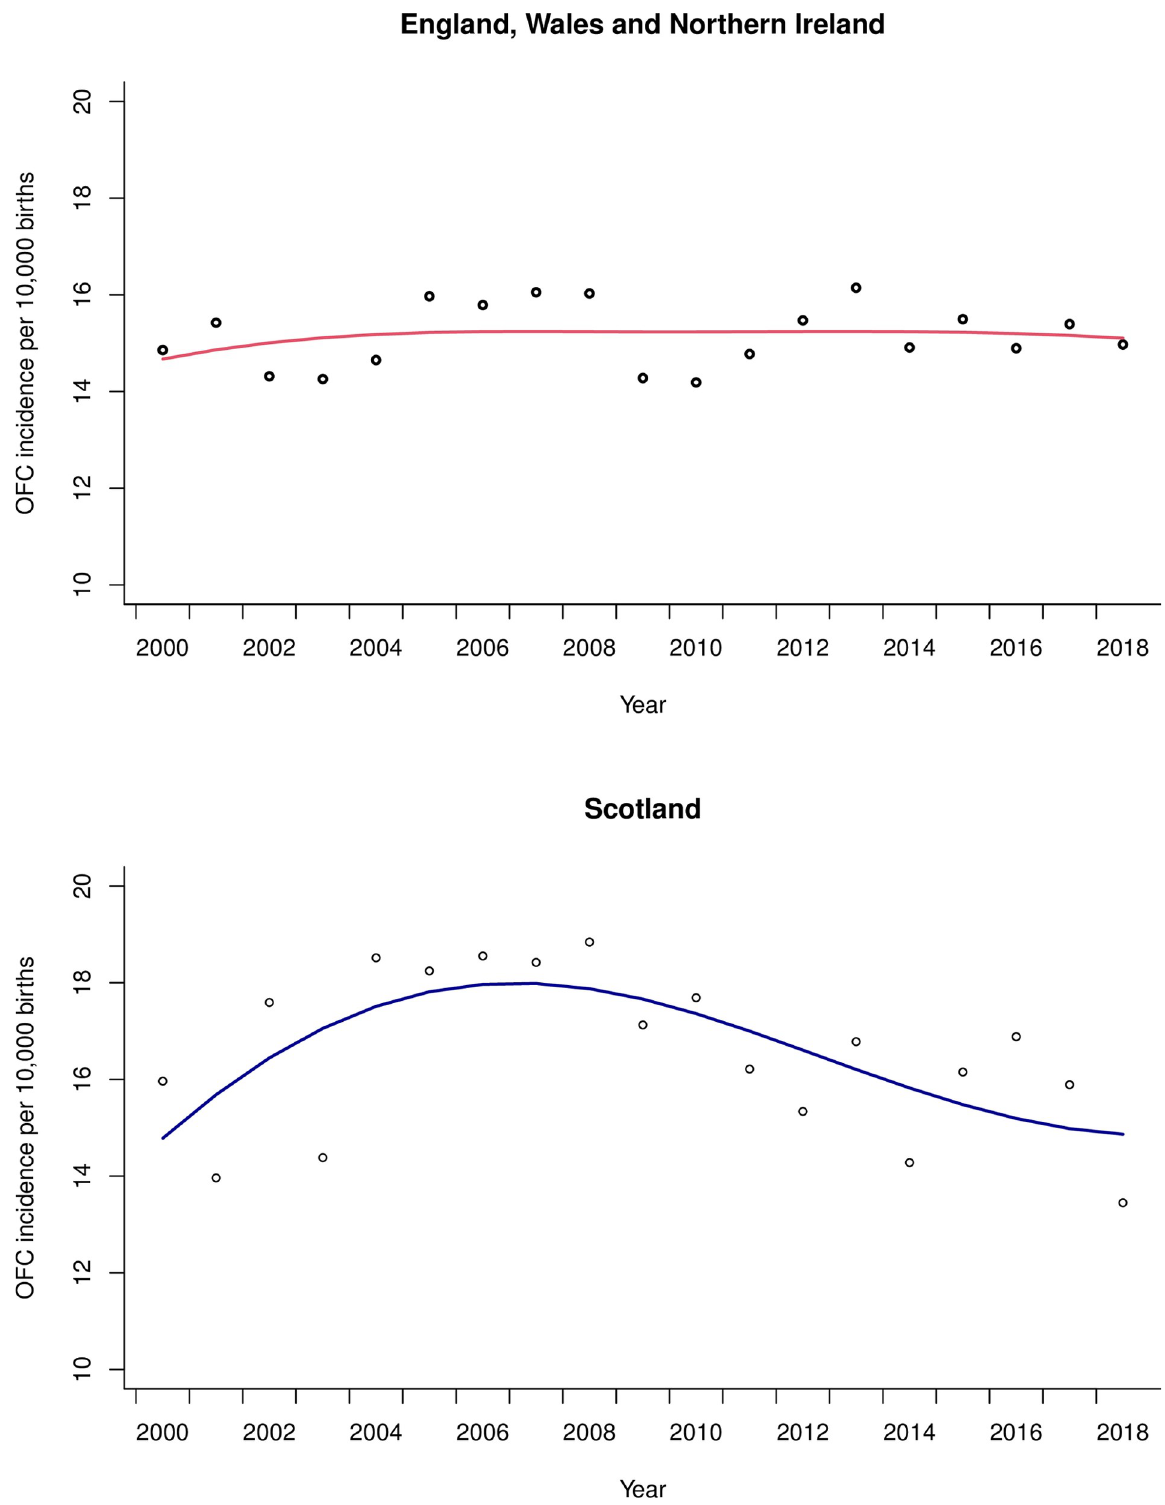
Fig 1. Quasi-Poisson regression line of orofacial cleft (OFC) incidence over time in EWNI and Scotland with long-term trends modelled using cubic flexible spline functions. The scatter are the raw annual data points.